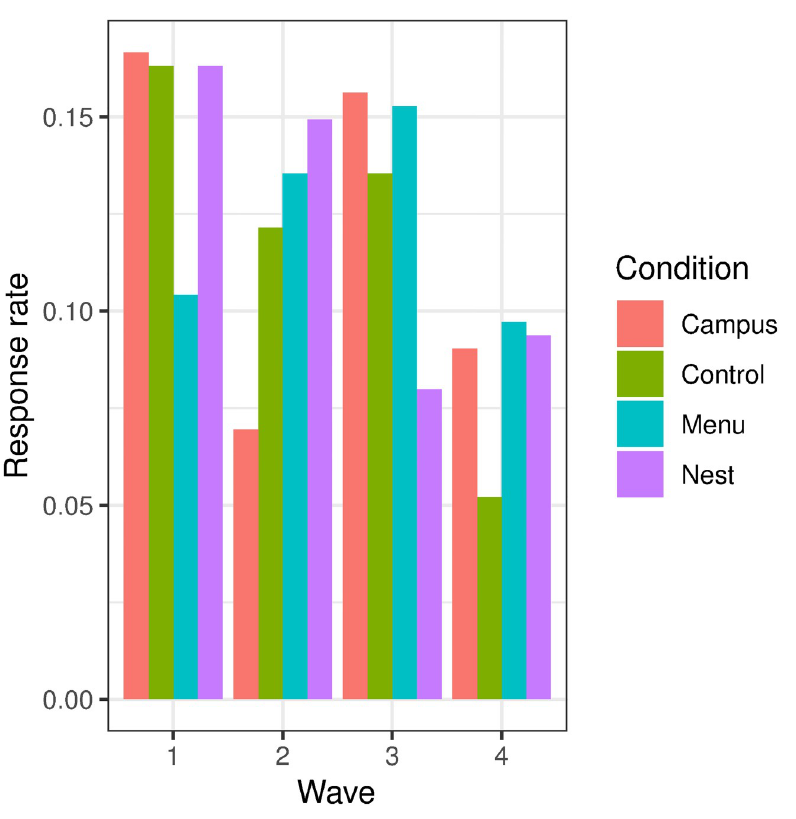
Fig 7. Response rates. The response rate for each survey wave by